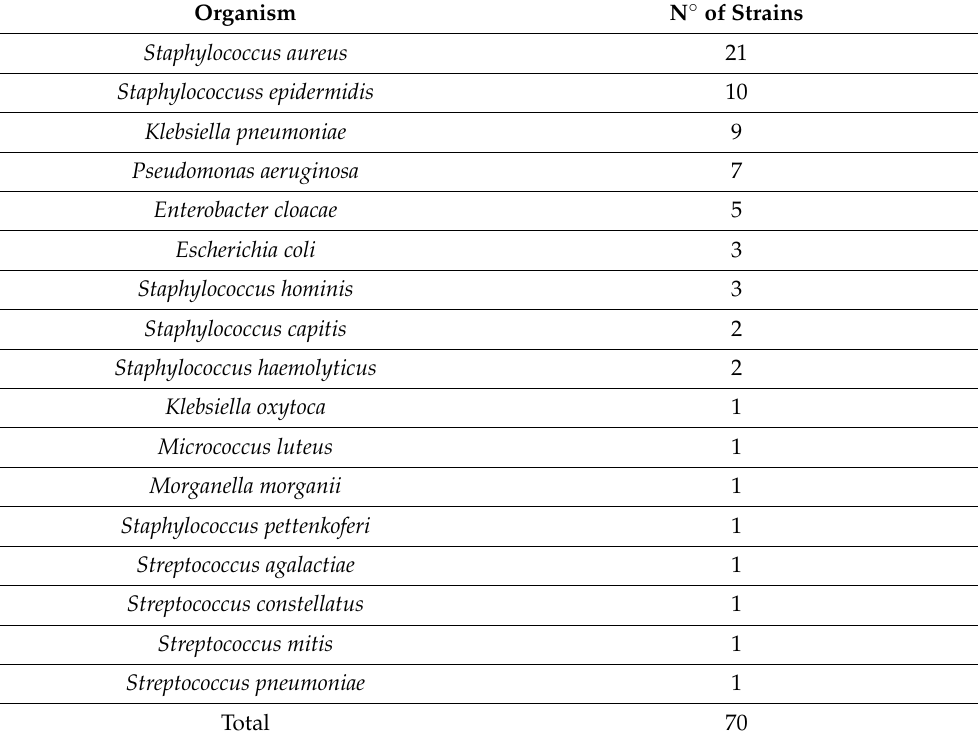
Table 1. Organism distribution retrieved from blood cultures during the clinical evaluation study. Organism N ◦ of